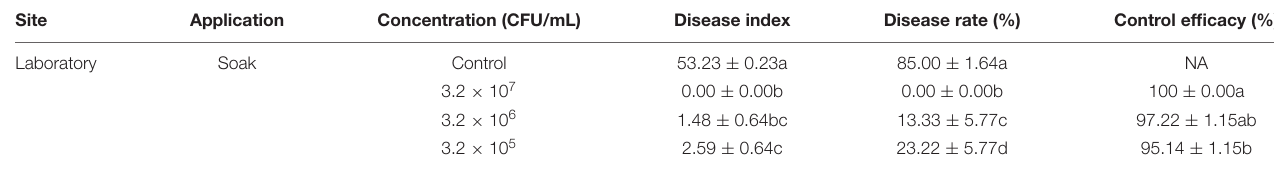
TABLE 3 | Effect of Bacillus amyloliquefaciens Y2 on tobacco mildew in laboratory. Site